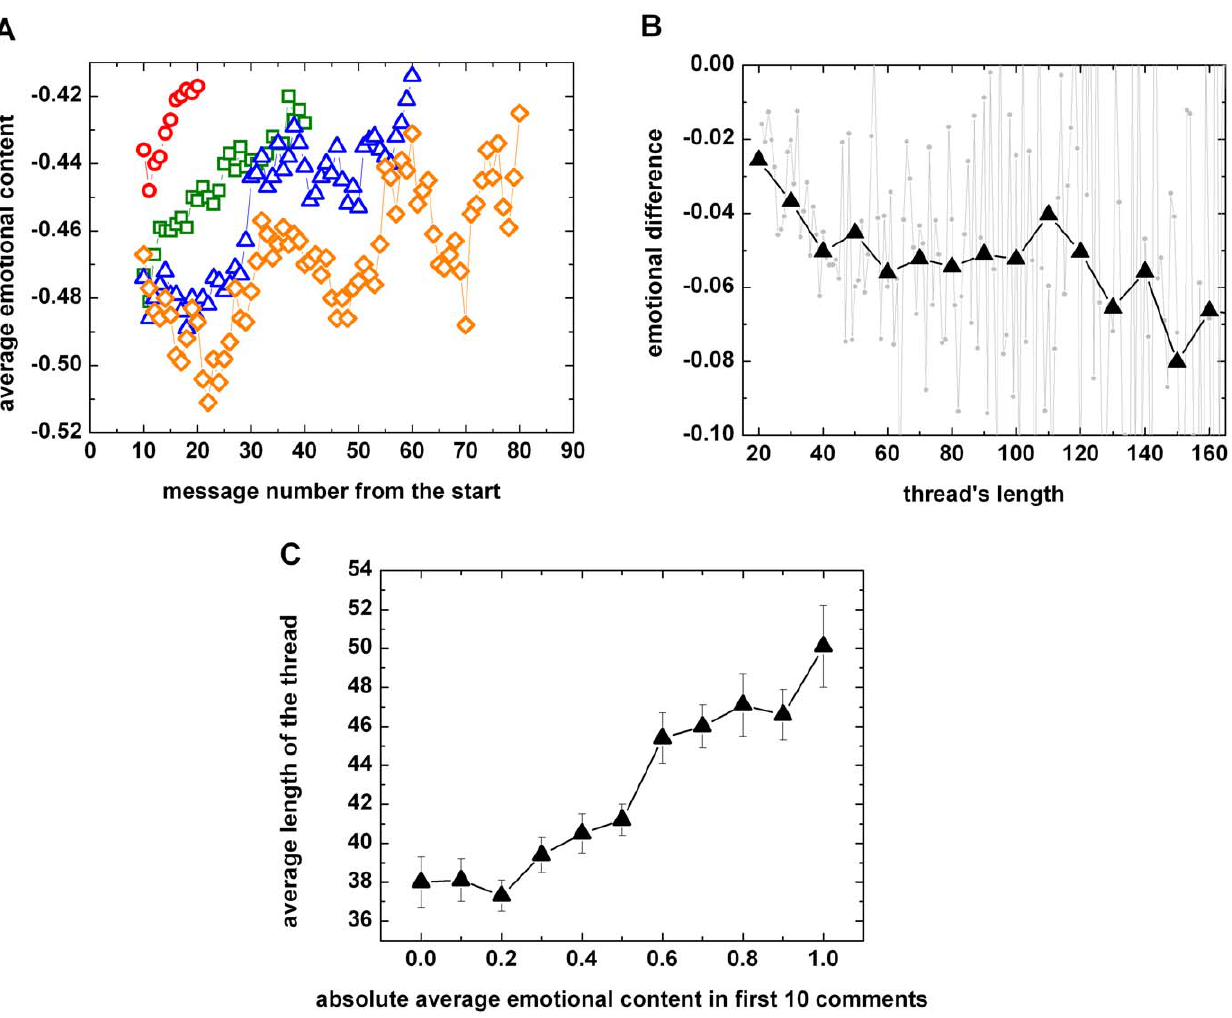
Figure 4. Time dependence of emotions in BBC forum threads. (A) Average emotion valence in the thread (moving average of the previous 10 messages in the thread). Four groups of threads of lengths 20, 40, 60 and 80 are represented by different symbols (respectively circles, squares, triangles and diamonds). Shorter threads start from emotional levels closer to zero. (B), Emotional level (valence) at the beginning of a thread minus the emotional level at the end as a function of thread length (grey symbols). Black triangles display binned data. Longer threads use more emotional ‘fuel’ over time. (C), Average length of the thread as a function of the absolute value of the average emotion valence of the first 10 comments. Emotional thread starts, whether positive or negative, usually lead to longer discussions. Error bars indicate standard